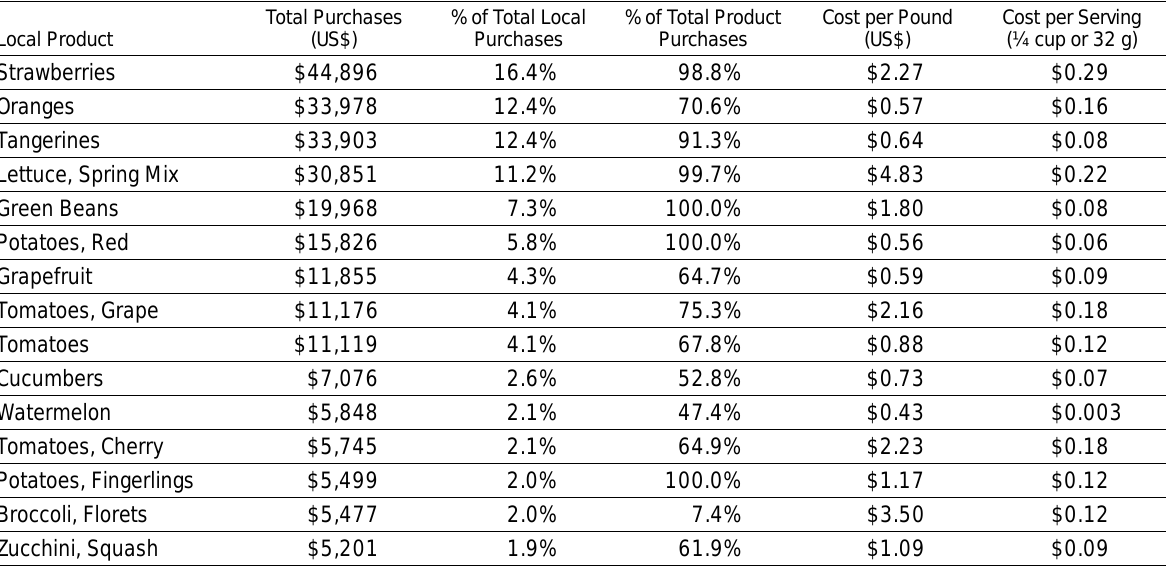
Table 2. Fresh Food Purchases by Market Value for Fruit and Vegetable